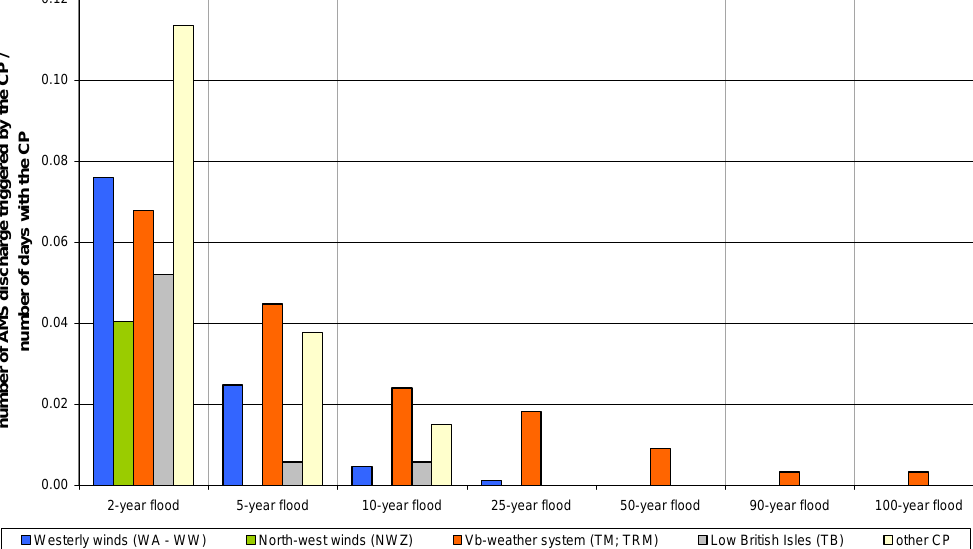
Fig. 9. Histogram of the circulation patterns at the gauge Golzern that generated AMS discharges between 1911 and 2002 (abbr. see Table 2).